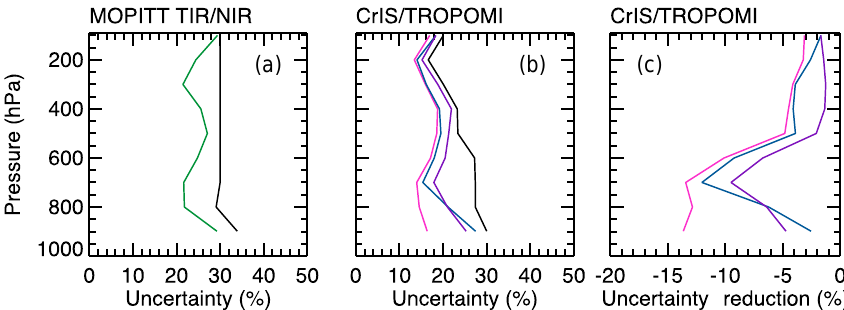
Figure 6. Uncertainties of the CO volume mixing ratio (VMR) profiles near 22.99 ◦ E, 8.65 ◦ S on 28 August 2013. (a) Uncertainty of the joint MOPITT multispectral CO products (green line) and a priori profile (black line). (b) Uncertainty of CrIS actual CO measurements (blue line), synthetic TROPOMI (purple line), and joint CrIS–TROPOMI (magenta line) CO measurements. Black line is the uncertainty of a priori profile used in the retrievals. (c) The reduction on the uncertainty with respect to the uncertainty of a priori